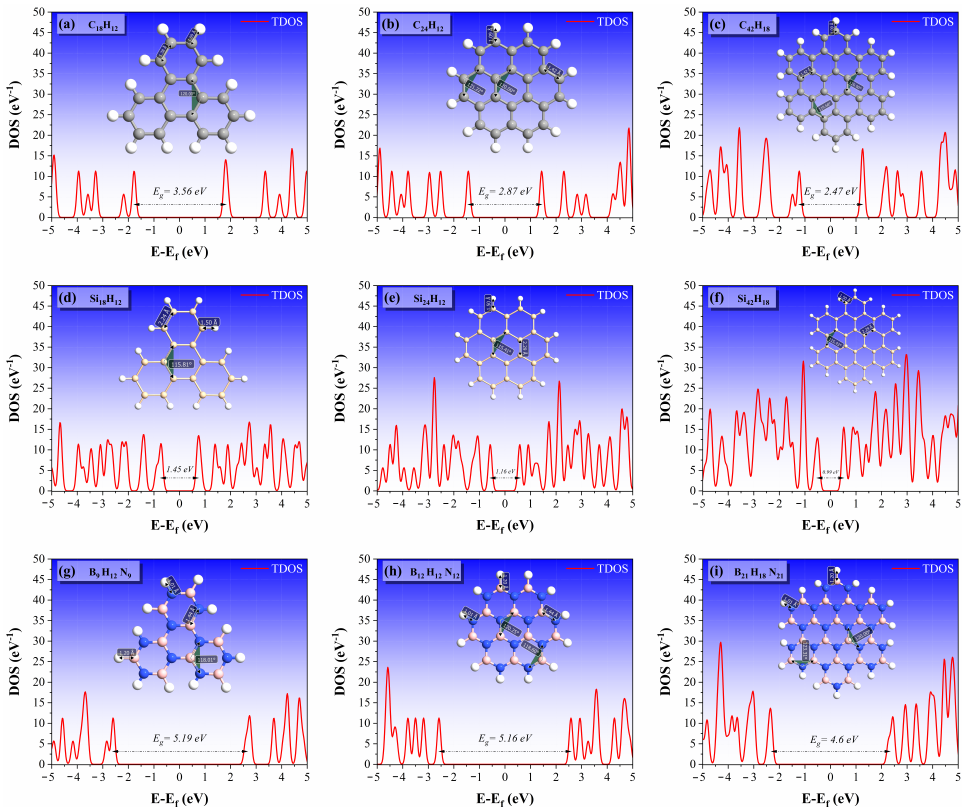
Figure 7. Total density of states (TDOS) of representative AT, ZH, and AH nanodiscs for ( a – c ) graphene, ( d – f ) silicene, and ( g – i ) h-BN. The optimized structures are shown inside the plots.